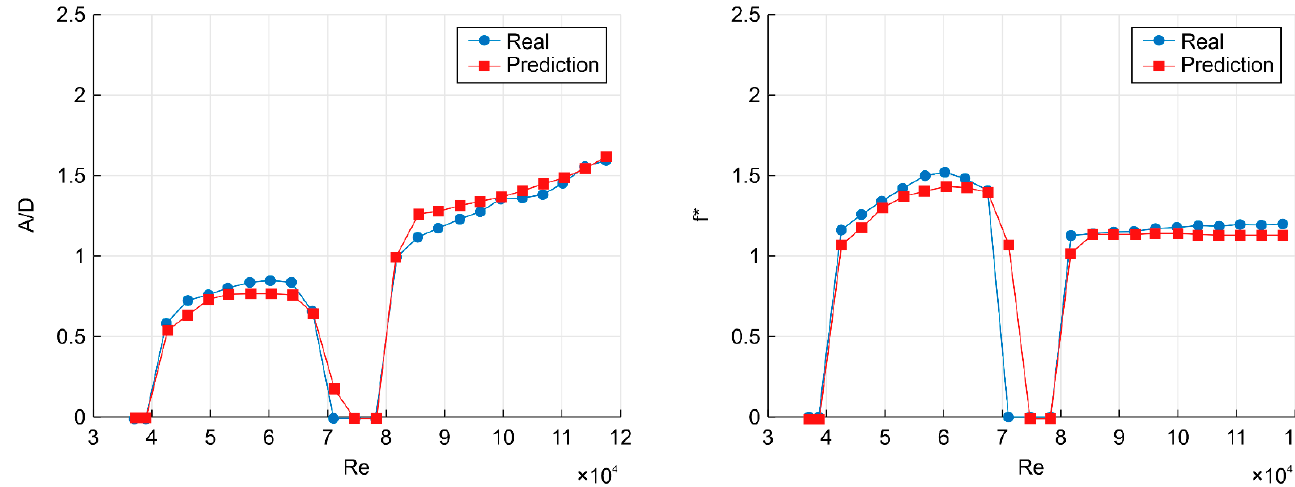
Figure 12. Cylinder amplitude (left) and frequency (right) with the real/predicted values for ζ harness = 0.16; K = 600 N/m.